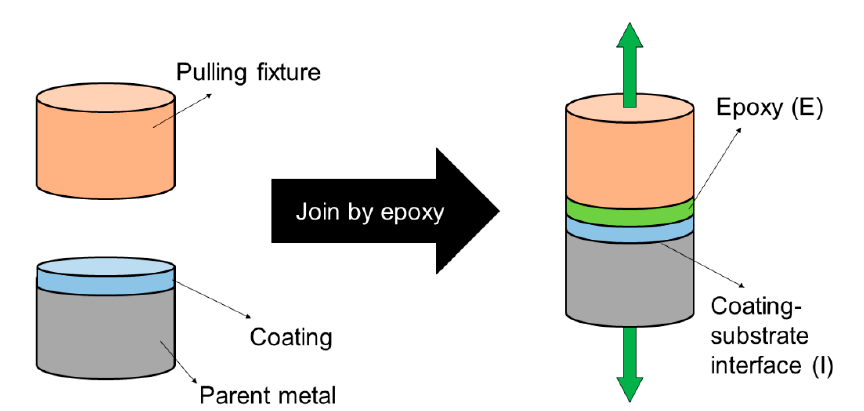
Figure 4. Setup for the adhesive bond test.